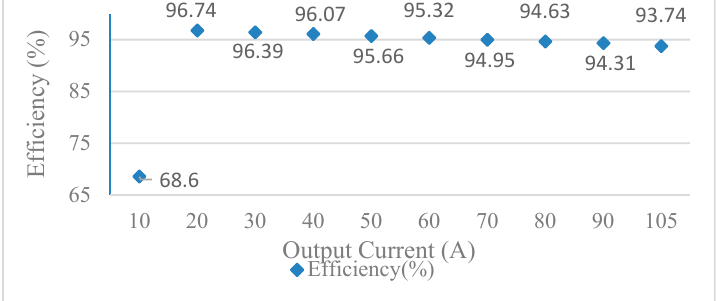
i Lr 1 : 5A/div; i Lr 2 : 5A/div; i Lr 3 : 5A/div).